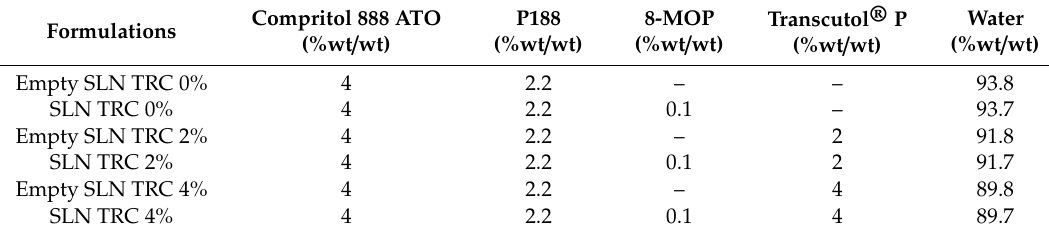
Table 1. Composition of 8-MOP-loaded and -unloaded